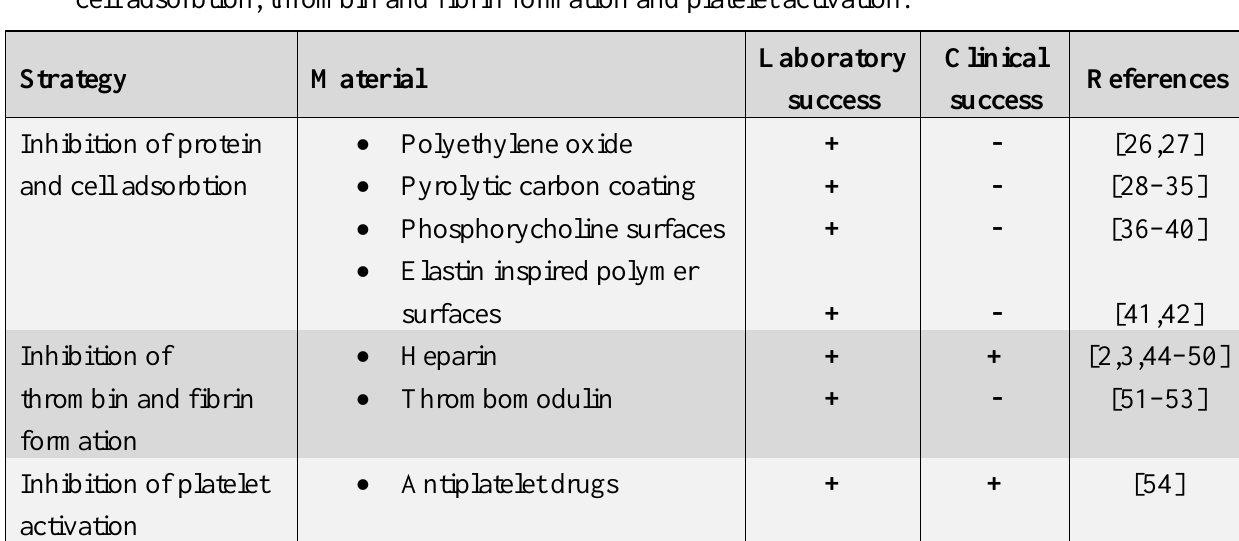
Table 1. Strategies to improve biomaterial hemocompatibility by inhibiting protein and cell adsorbtion, thrombin and fibrin formation and platelet